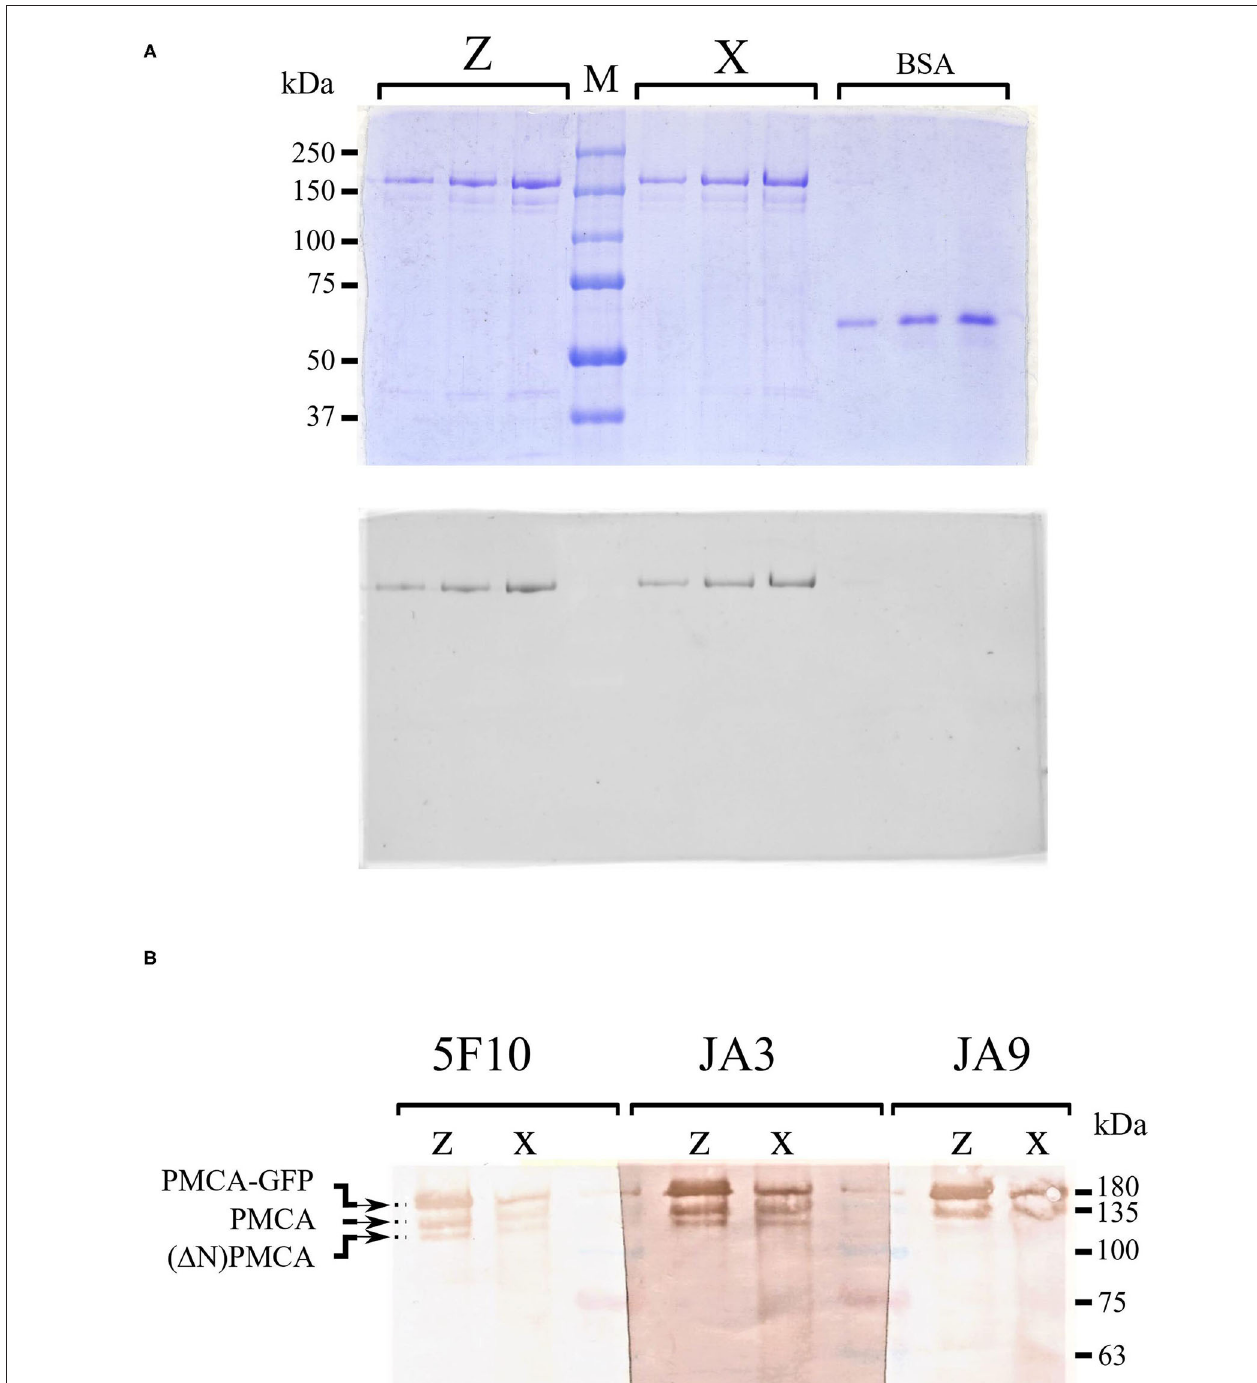
FIGURE 4 | (A) Sodium dodecyl sulfate–polyacrylamide gel electrophoresis (SDS-PAGE) of purified PMCA4xb-GFP and PMCA4zb-GFP. The recombinant PMCA proteins were purified as described in “Materials and methods.” Aliquots of the eluate containing the purified proteins were submitted to electrophoresis in a 7.5% SDS–PAGE. Three lanes containing 0.25, 0.5, and 0.75 µ g of PMCA4xb-GFP and PMCA4zb-GFP are shown. For comparison 0.3, 0.6, and 0.9 µ g of bovine serum albumin were run on the right side of the gel. On top , the gel was stained with Coomassie-blue. On the bottom , the GFP-fluorescence of the same gel is shown. (B) Western blots of purified PMCA4xb-GFP and PMCA4zb-GFP. Western blots of purified PMCA4 preparations with antibodies 5F10, JA3, and JA9. Aliquots of 6 µ l (about 1 µ g of protein) of PMCA4xb-GFP and PMCA4zb-GFP eluates were loaded.